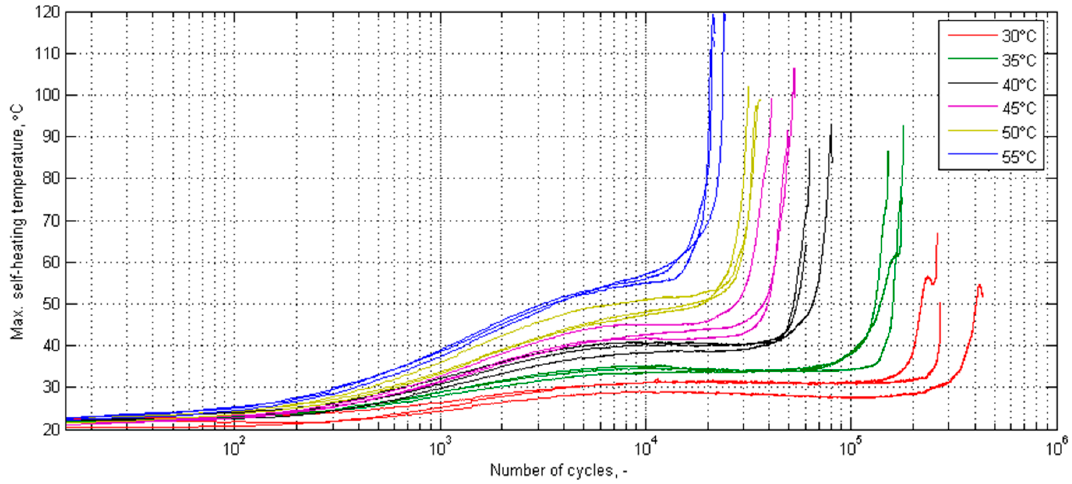
Figure 19. Selected self-heating temperature history curves for various temperature stabilization values.